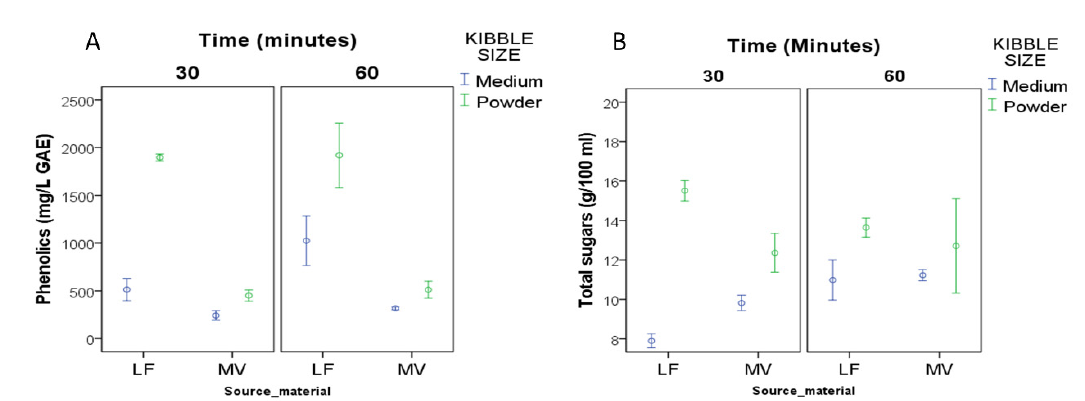
Figure 1. Interaction plots for total phenolics and sugars obtained by heat-assisted extraction (HAE; ( A , B )) of different source materials (LF: Lefkaritiki; MV: Mavroteratsia) and kibble sizes (medium and powder). HAE extraction varied in time (80, 160, 240, 320 min) and temperature (25, 50, and 75 °C). Data points represent means of three replicates with standard error bars.